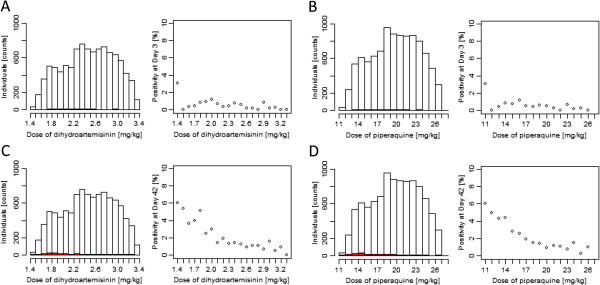
Predicted parasite positivity at Day 3 and 42 in a global population of 10,000 individuals dosed by weight with dihydroartemisinin-piperaquine (DHA-PPQ). Panels show predicted parasite positivity for DHA and PPQ at Day 3 ((A) and (B), respectively) and at Day 42 ((C) and (D), respectively). Left of panels: Total numbers of individuals per mg/kg dosing band (white) and individuals that were parasiaemic (i e, parasite number > 108) (red). Right of panels: Numbers expressed as a percentage.